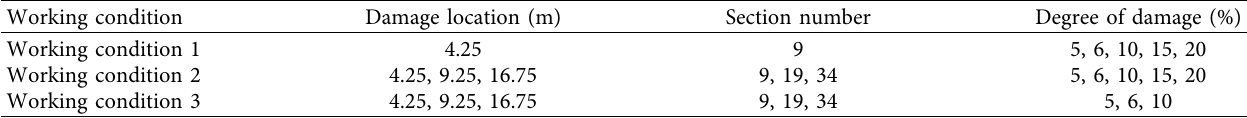
Figure 2: Structural layout of simply supported Table 1: List of working conditions used in the study.